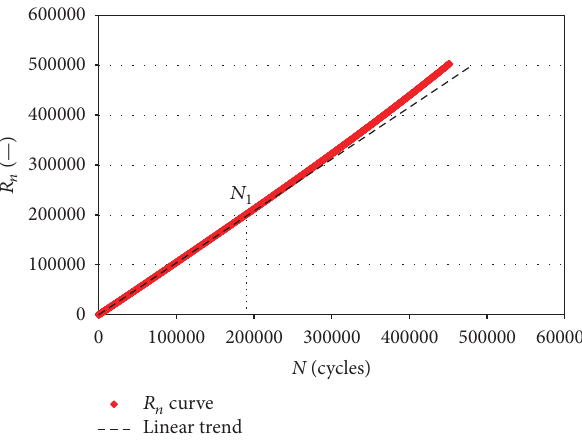
Figure 3: Determination of 𝑁 1 for mix HM/R2 at 400 𝜇